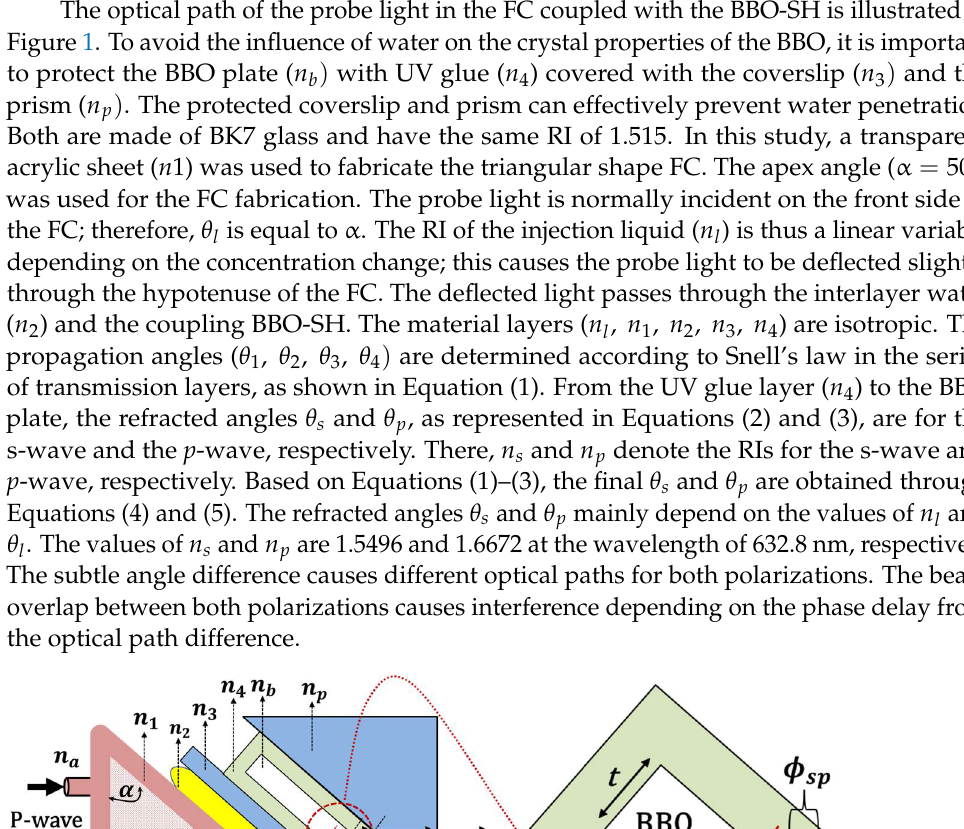
Figure 1. The optical path of the probe light through the FC, the interlayer water, and the BBO-SH. Assume the initial phase delay ( φ i ) between two orthogonal polarizations is equal to zero in the UV glue layer; the final phase delay after passing through the BBO with thickness t at probe wavelength λ is expressed as Equation (6). When the probe light has a normal incidence on the front side of the FC, θ l is equal to α .